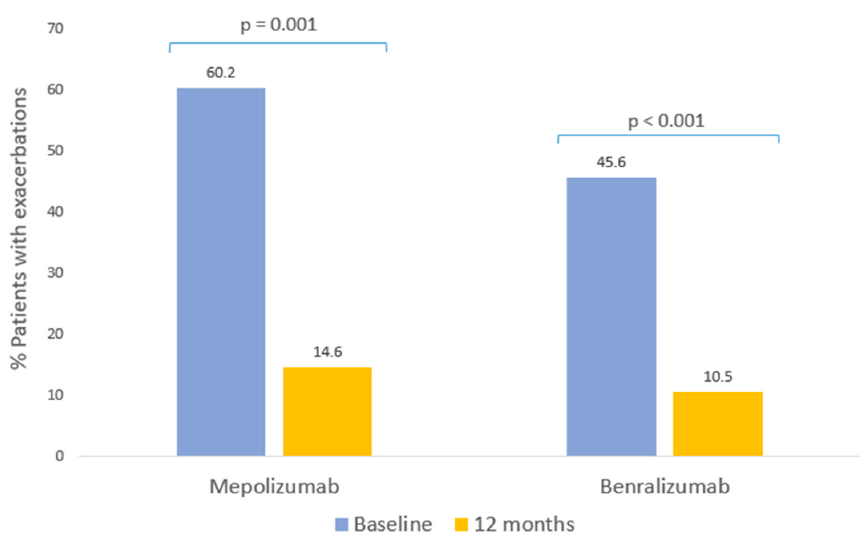
Figure 3. Clinical response to biological therapies: exacerbations. Patients with at least one exacerbation in the 12 months prior to starting mepolizumab and benralizumab, and at follow-up evaluation after 12 months of therapy.